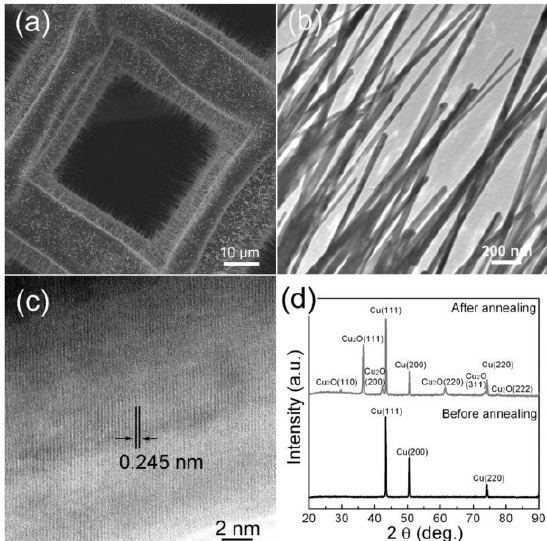
Figure 5. The SEM image (a) and the TEM image (b) of Cu 2 O nanowires produced by heat treatment on Cu grid. (c) a HRTEM image of a so-produced Cu 2 O nanowire. (d) XRD patterns of Cu grid before (the bottom) and after heat treatment (the top).